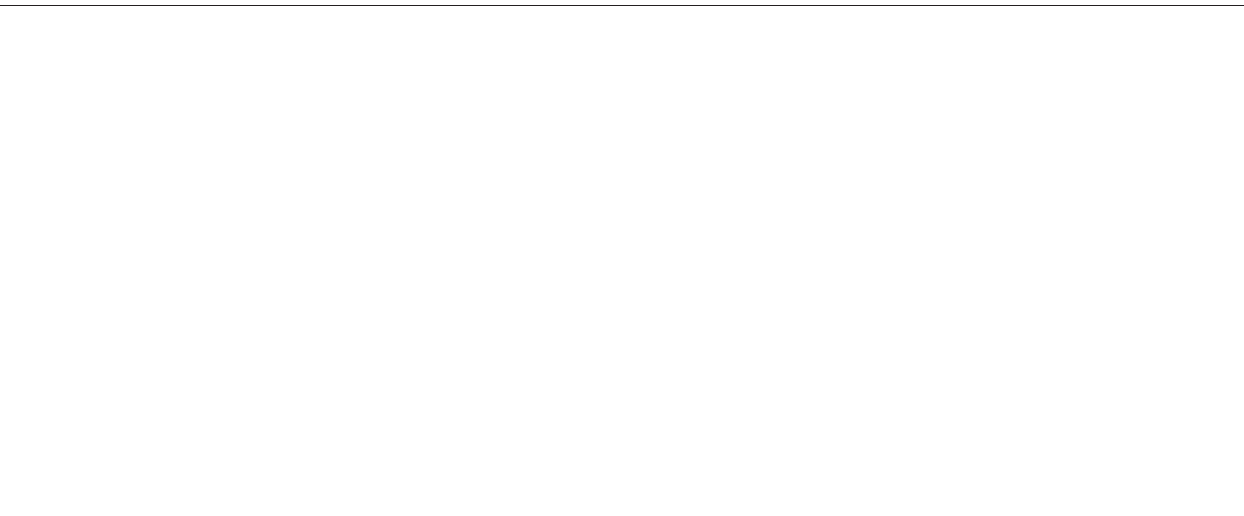
FIGURE 3 | The 35S rDNA expression analysis in the different tissues of B. hybridum (genotypes 3-7-2 and ABR113) and B. stacei (genotype ABR114; control) and B. distachyon (genotype Bd21; control) using the RT-PCR CAPS method. (A) The Mlu I restriction profile of the B. distachyon -like and B. stacei -like ITS1 PCR products. The expected sizes of the bands after Mlu I digestion are presented. (B) The Mlu I restriction profiles of ITS1 amplification products that were obtained from the leaves cDNAs of B. distachyon and B. stacei . (C) The Mlu I restriction profiles of ITS1 amplification products that were obtained from the primary roots, leaves, adventitious roots, and immature spikes cDNAs. Adv. Roots, adventitious